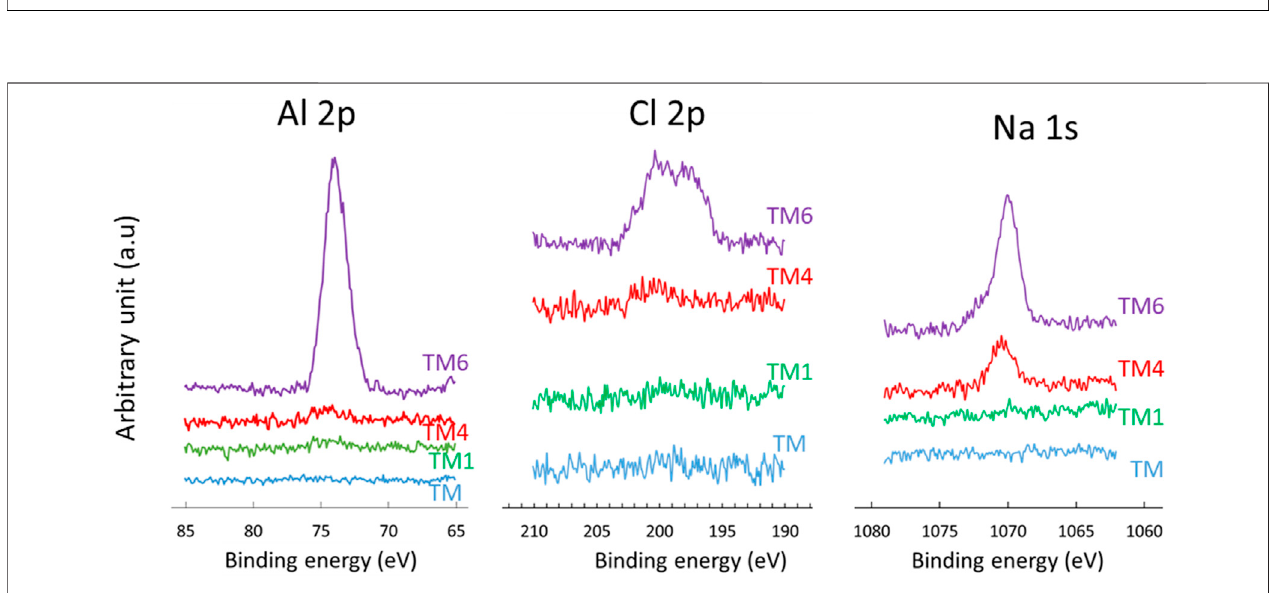
FIGURE8| High-resolutionXPSAl2p,Cl2pandNa1sspectraofaluminiumcoatedwithTMcoatingbeforeimmersionandafterselectedimmersiontimesin0.1 M NaCl (TM1 after 1 day, TM4 after 4 days and TM6 after 6 days). Spectra were not normalized on the intensity scale.